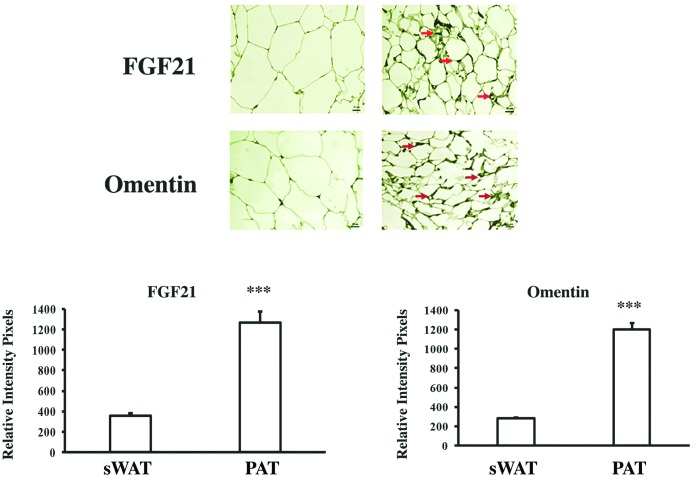
Expression of FGF21 and omentin in subcutaneous adipose tissue (sWAT) and periaortic adipose tissue.Representative image showing immunohistochemical staining for FGF21 and omentin (n = 8). A paired t-test was applied to determine significant differences between averages. (***) p<0.001 indicates a statistically significant difference in the levels of FGF21 and omentin expression between sWAT and PAT.